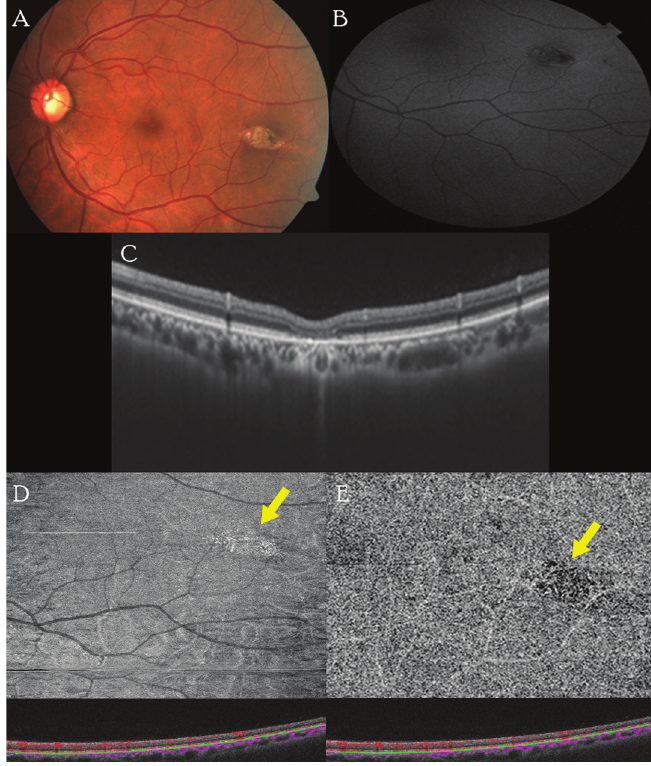
Figure 1. (A) Color photograph of the left eye showing a hypopigmented torpedo-shaped lesion with a hyperpigmented tail. (B) FAF showing hypoautofluorescence with a border of hyper autofluorescence at the tail end. (C) OCT of the lesion showing disruption of the IS-OS junction and atrophy of the outer nuclear layers and increased choroidal reflectance. (D) Infrared reflectance imaging of the choroidal layer showing heterogenous reflectivity with hyperreflectivity at the tail end (yellow arrow). (E) OCT-A of the choriocapillaris layer showing diffuse attenuation of flow signals (yellow